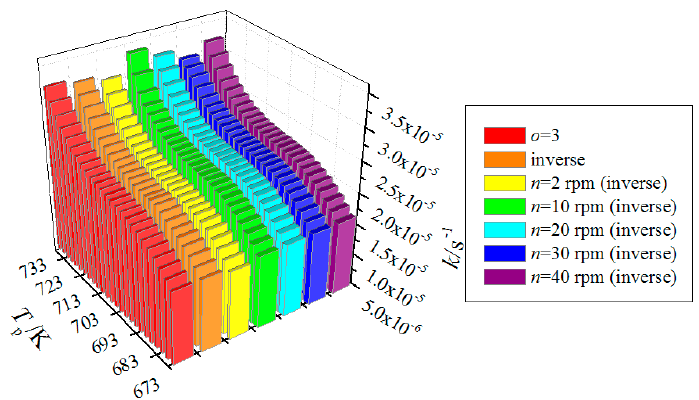
Figure 11. Comparisions of reaction rate constants between the modified Arrhenius equation ( o = 3), inverse method, and screw-speed-dependent inverse method. Table 4. Relative errors of NAMW of PEW at four measure points (N4, N5, N7, and N11) for the modified Arrhenius equation ( o = 3), inverse method, and screw-speed-dependent inverse method. Relative Error